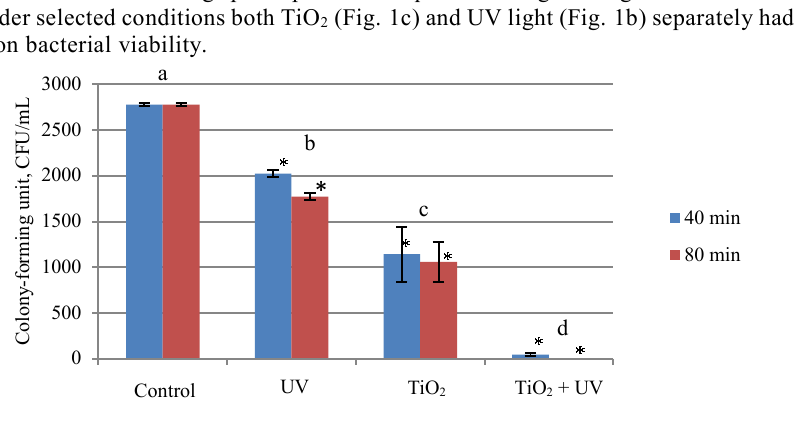
Fig. 1 Viability of E. coli cells assayed by spread plate technique ( n = 3): a) negative control with not irradiated cells; b) effect of UV; c) effect of TiO 2 ; d) effect of TiO 2 + UV. The experiments were performed at 22 °C, the initial number of bacteria was 2.7×10 6 cfu/mL, dilution factor 1000. 1 mg/mL of TiO 2 was used and the intensity of UV irradiation was 2 mW/cm 2 . *statistically significant difference compared to control group, using one-way ANOVA, p <